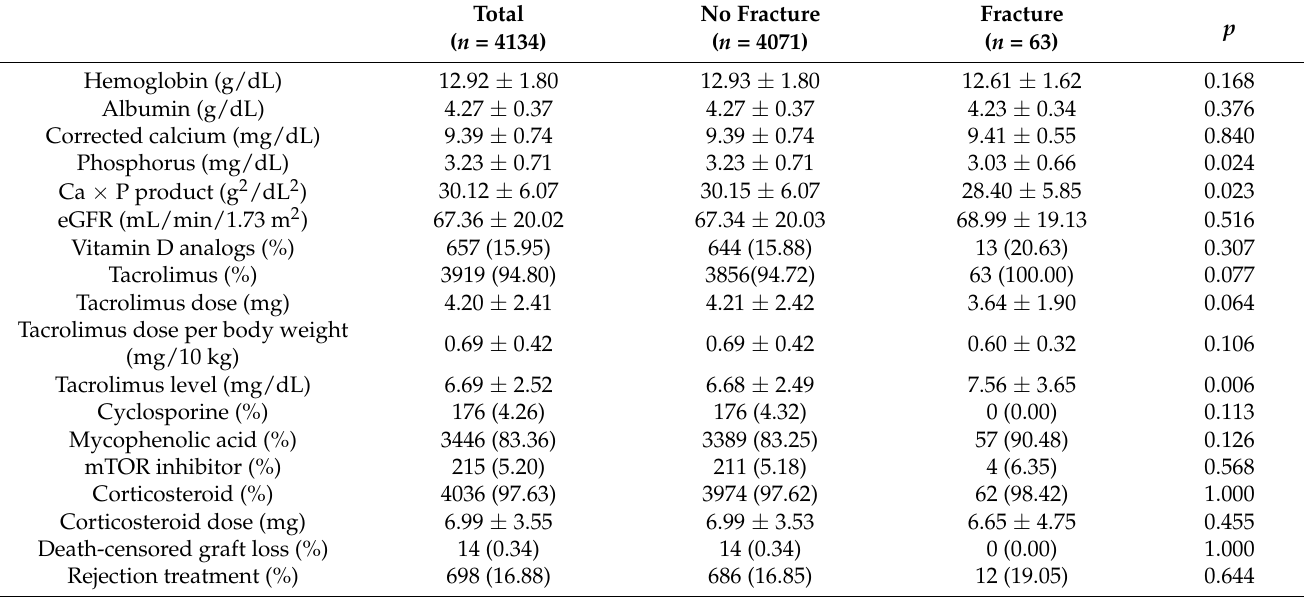
Table 2. Clinical characteristics of the kidney transplant recipients at 6 months post-transplantation.